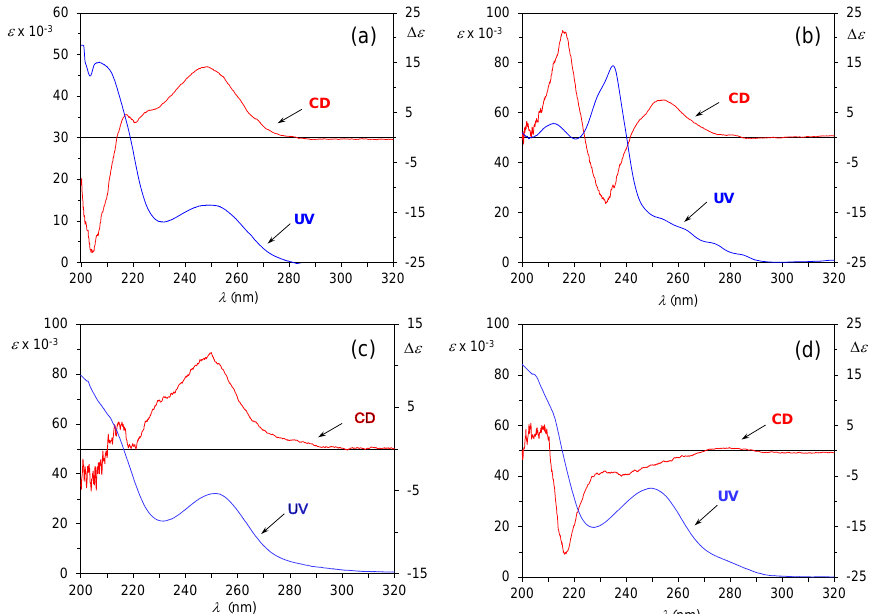
Figure 4. UV and ECD spectra (THF) of biphenylamides ( S )- 4aa panel ( a ), ( S )- 4ba panel ( b ), ( S )- 4ca panel ( c ) and ( R )- 4da panel ( d ).